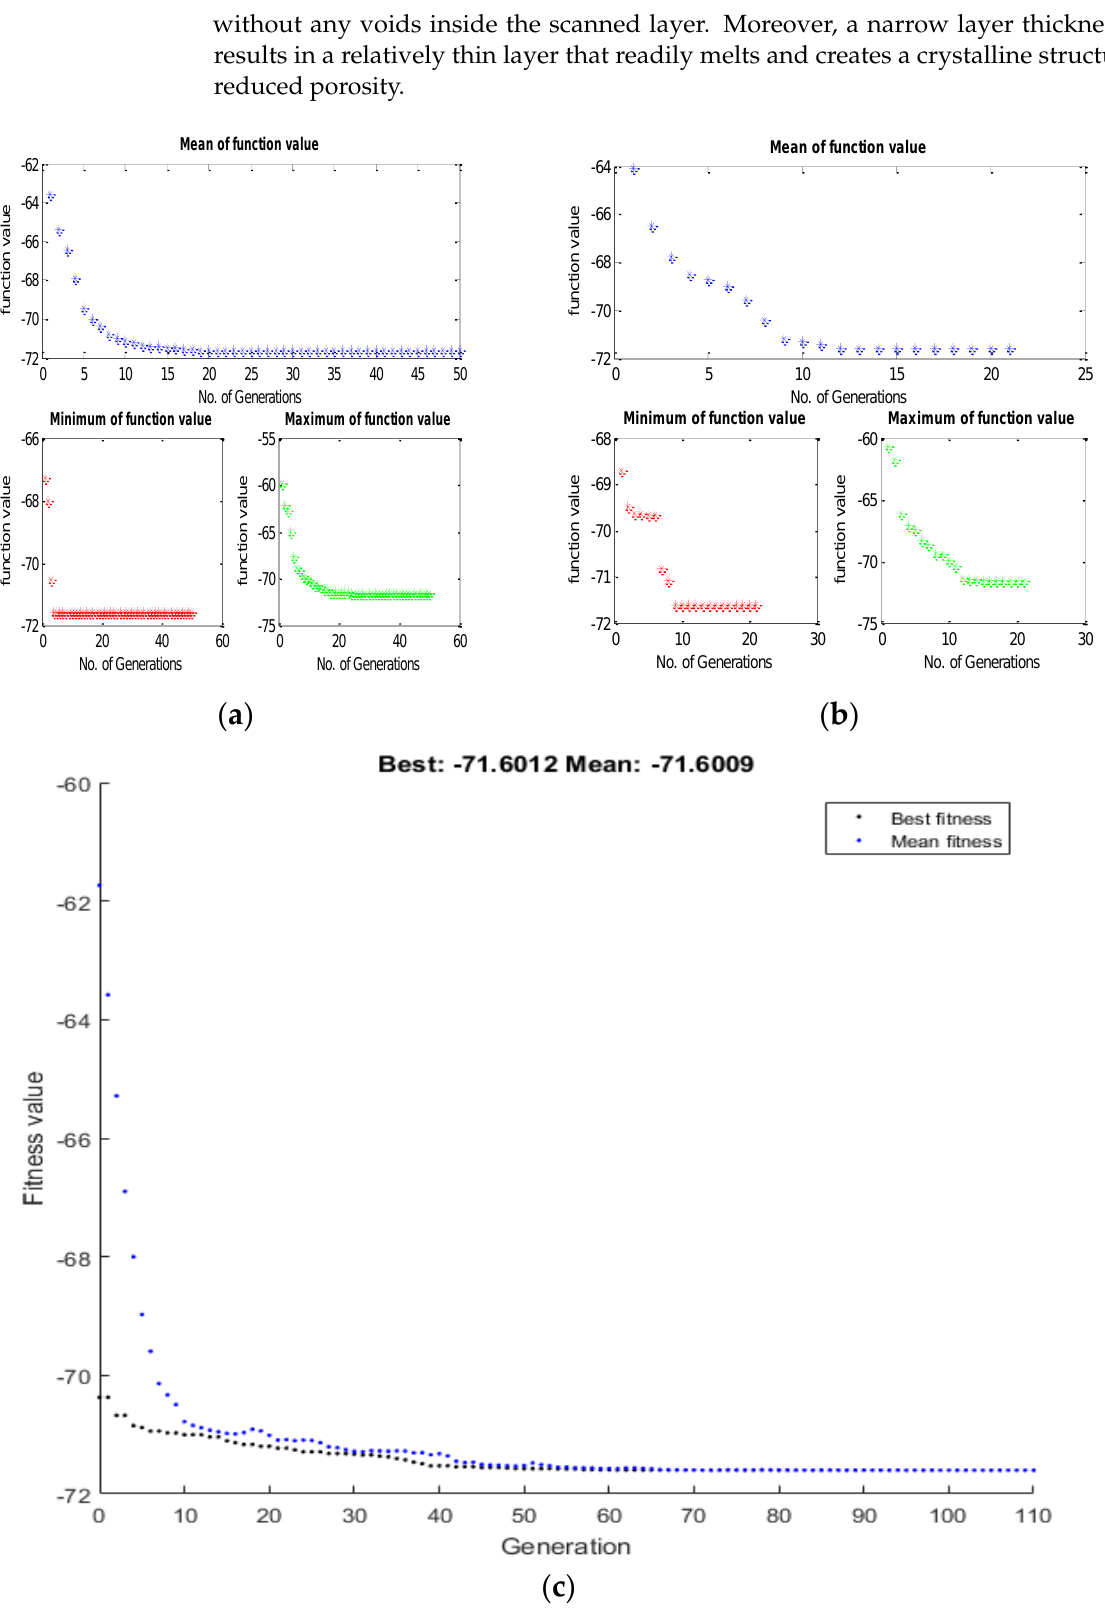
Figure 3. Convergence plot for the hardness by ( a ) TLBO ( b ) JAYA & ( c ) Genetic Algorithm.